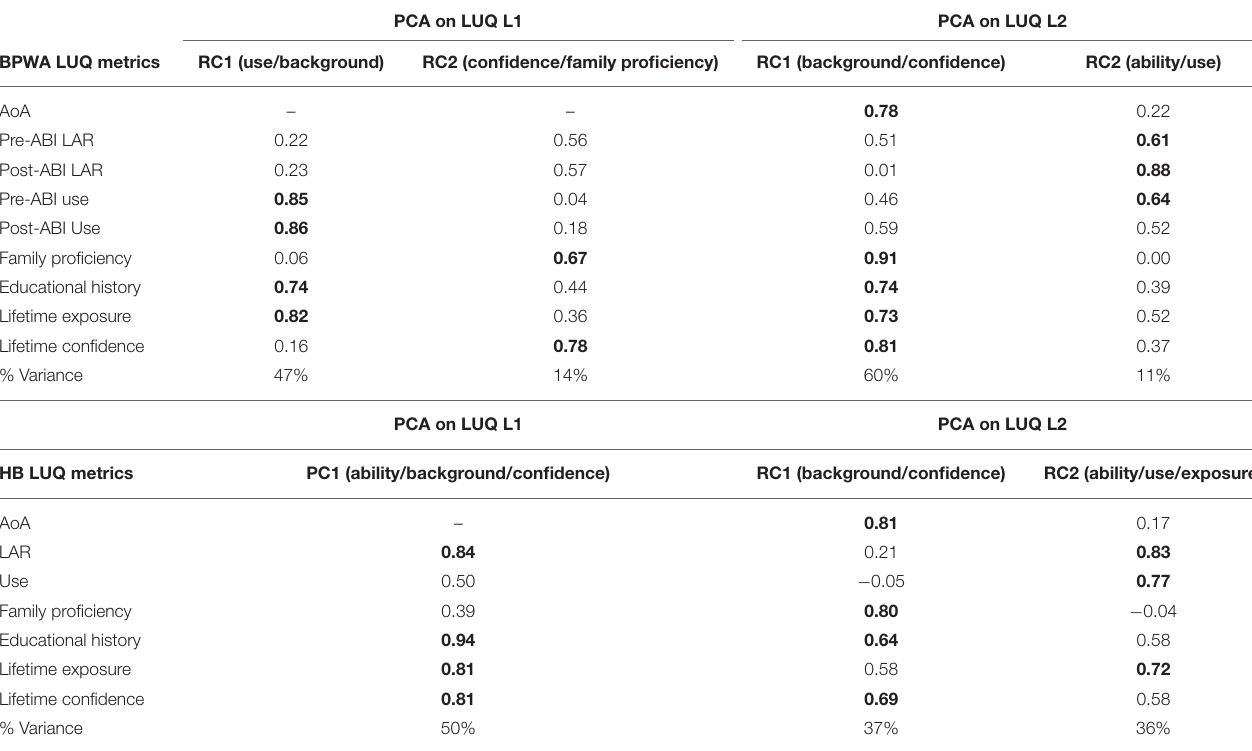
TABLE 2 | Results of the principal component analysis conducted on L1 and L2 for bilingual people with aphasia and healthy bilinguals. PCA on LUQ L1 PCA on LUQ L2 BPWA LUQ